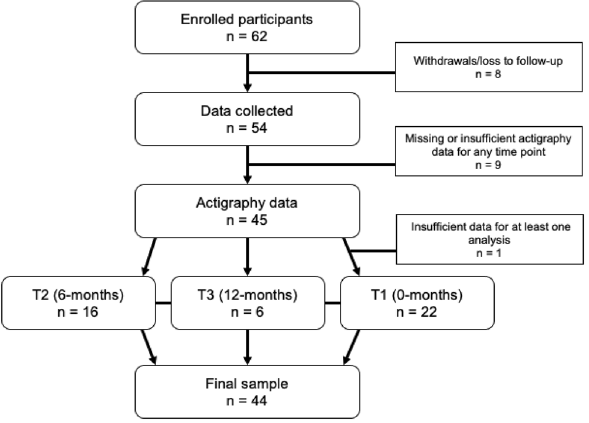
Figure 4. Participant flow diagram. ( Note Data were pooled from the 6-month, 12-month, and then baseline time points, respectively, T time